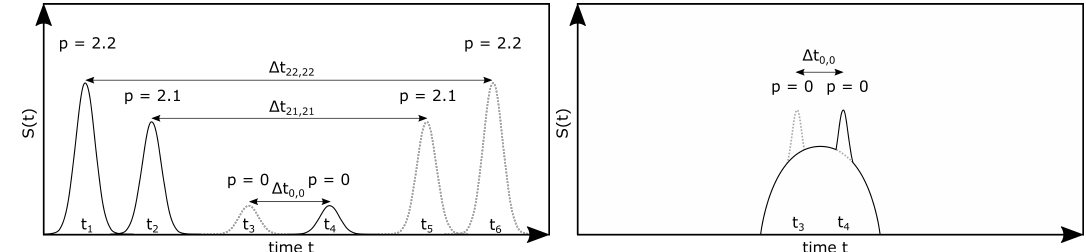
Figure 4. Signal of scattered light from a transparent (n = 1.333) (left) and an opaque (right) droplet in ϑ S = 165 ◦ while passing the laser beams. Detector D1 is shown in gray with dotted lines, detector D2 in